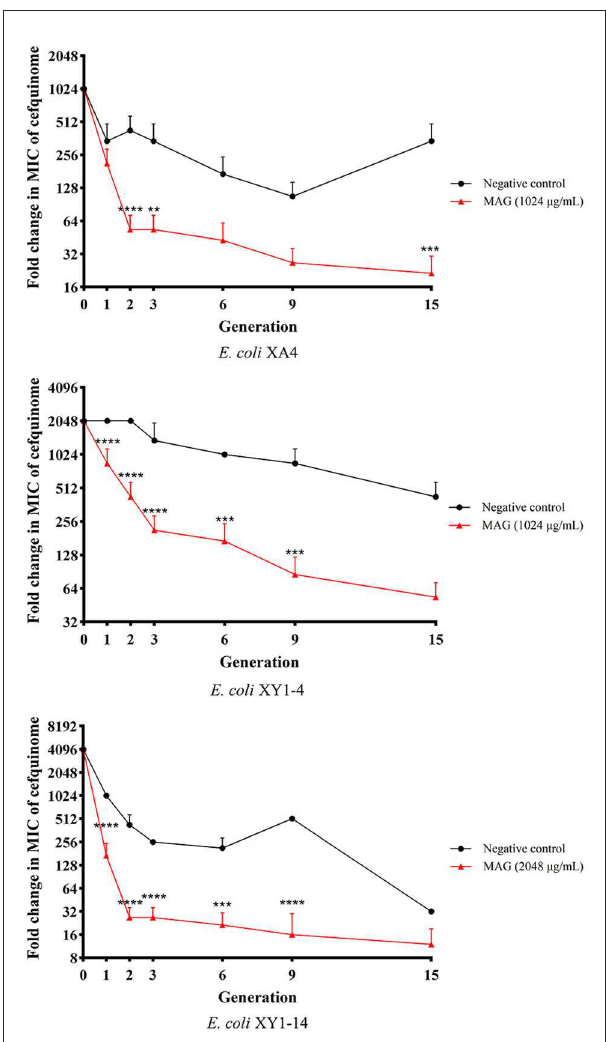
FIGURE5 Effect of magnolol (MAG) on changing the sensitivity of MDR E. coli to cefquinome. All data are expressed as mean ± SD determined from three independent experiments performed in triplicate. ns P > 0.05; ** P < 0.01; *** P < 0.001; **** P <